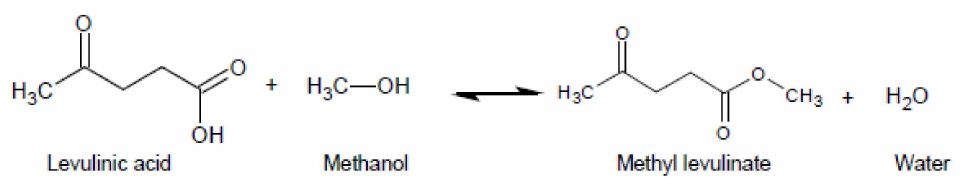
Figure 1. Esterification reaction of levulinic acid with